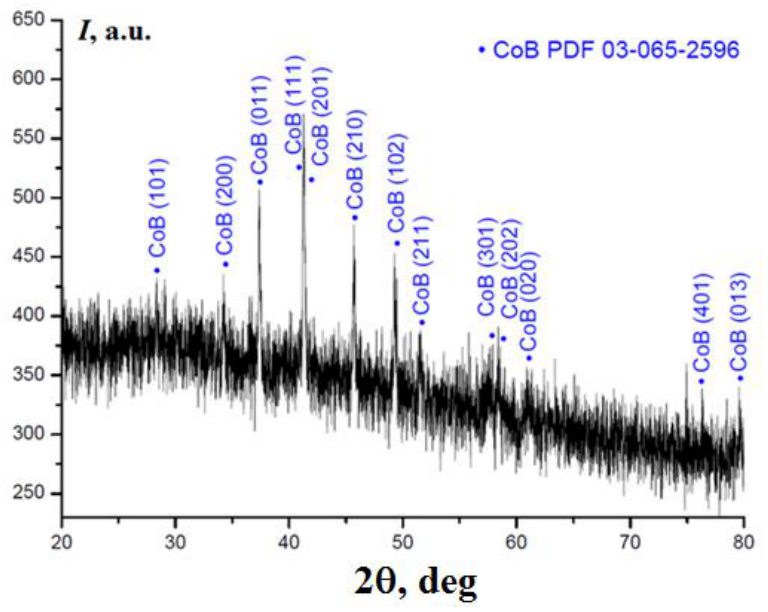
Figure 7. X-ray powder diffraction pattern for sample 3a .